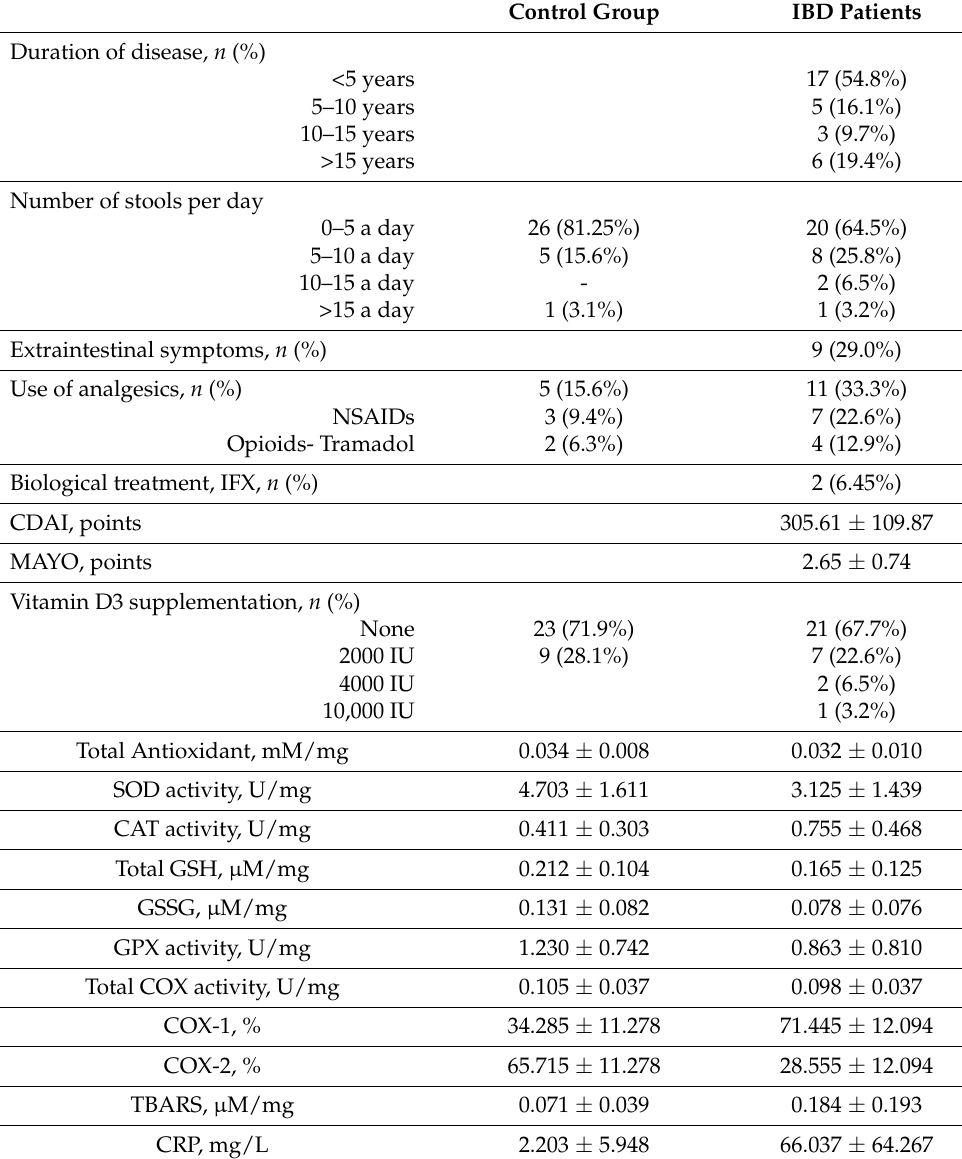
Table 2. Clinical data of inflammatory bowel disease (IBD) patients and